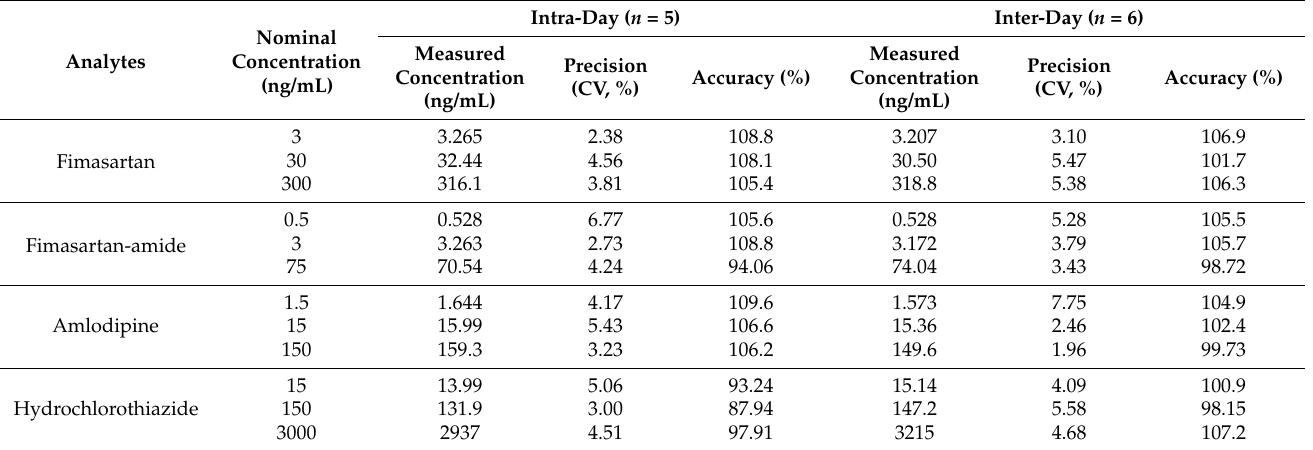
Table 2. Intra- and inter-day precision and accuracy of fimasartan, fimasartan-amide, amlodipine, and hydrochlorothiazide.